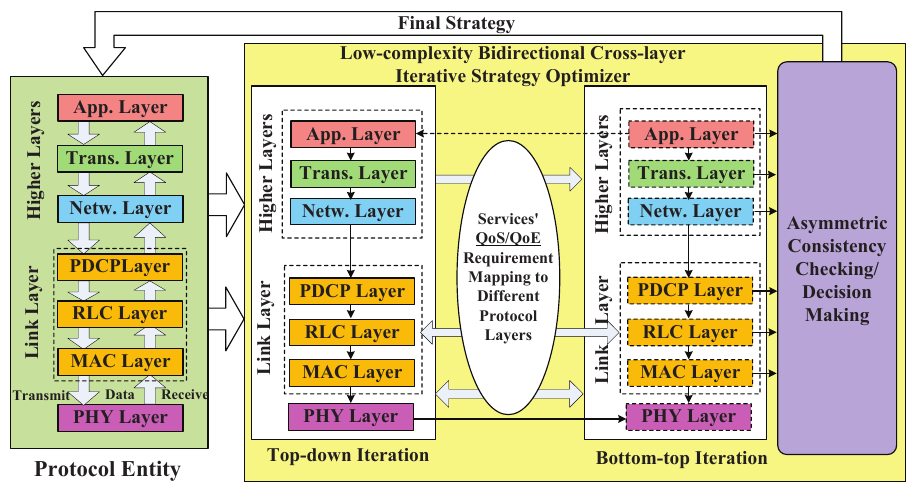
Figure 6. Tightly coupled cross-layer framework with service-awareness achieved via bidirec- tional iterative strategy optimization (using the typical architecture of a protocol stack in 3GPP as an